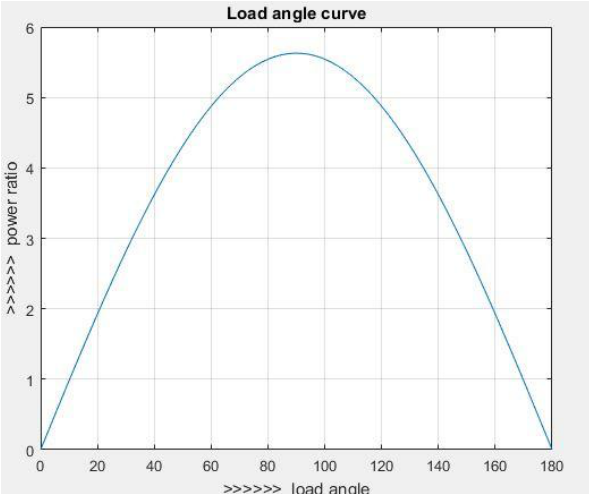
/P - δ characteristics for without R o